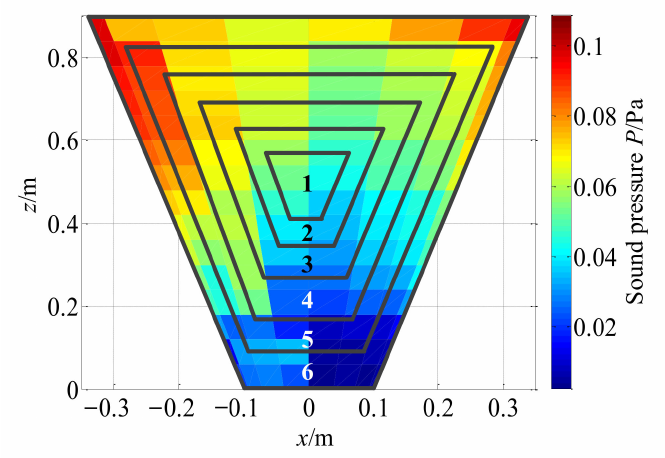
Figure 26. Different regions on the reconstruction surface.